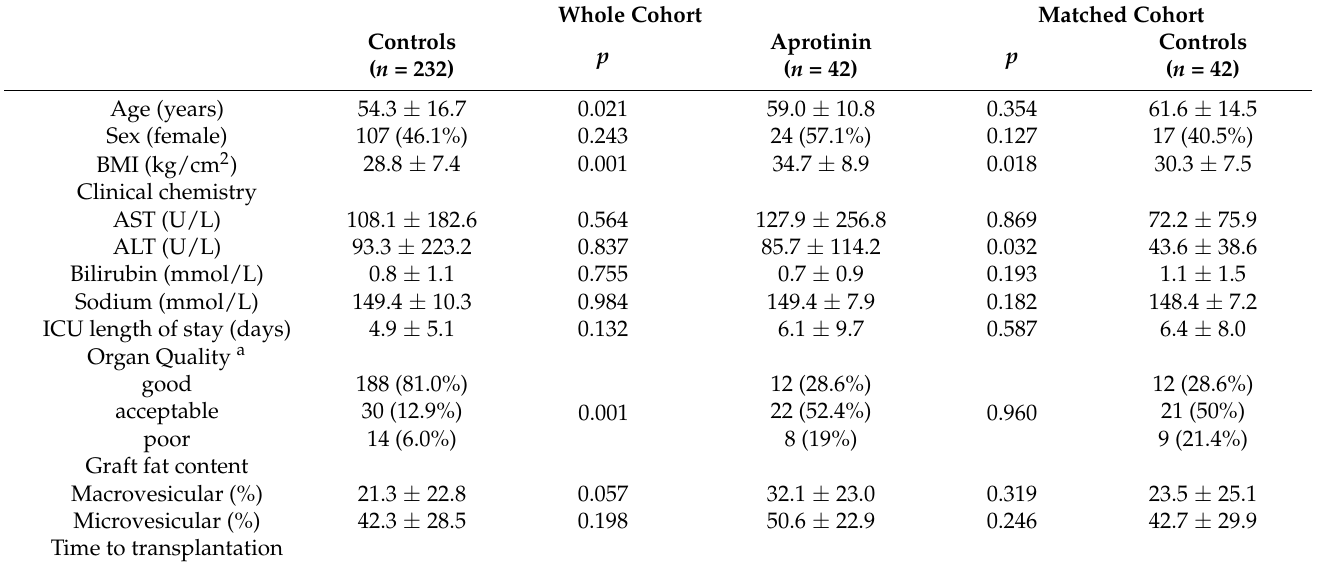
Table 2. Demographic and clinical characteristics of the liver graft donors and grafts data for 42 liver graft recipients who were intraoperatively treated with aprotinin and 42 controls. The 42 statistically similar recipients who were not treated with aprotinin were identified by propensity score matching in a cohort of 274 single center liver graft recipients. Propensity scores were calculated using organ quality, cold ischemia time and donor